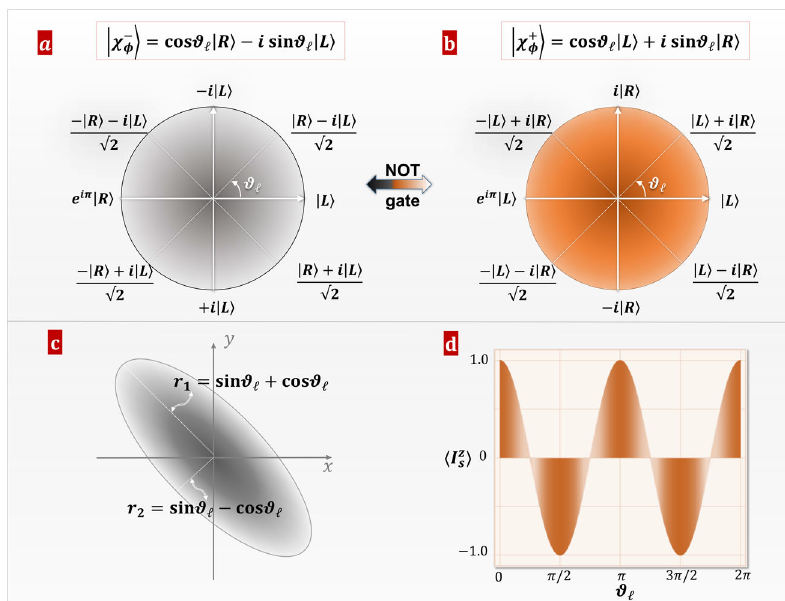
Fig. 4 OAM-based AFM logic gates. a and b Logic gates realized by the OAM-balanced twisted AFM chiral magnon states with opposite topological charge ℓ . c Corresponding elliptical precession orbit of the chiral magnon state j χ (cid:3) ϕ i in the x – y plane. d Pumped spin accumulation for which the DC component is given by the area of the ellipse: hI z